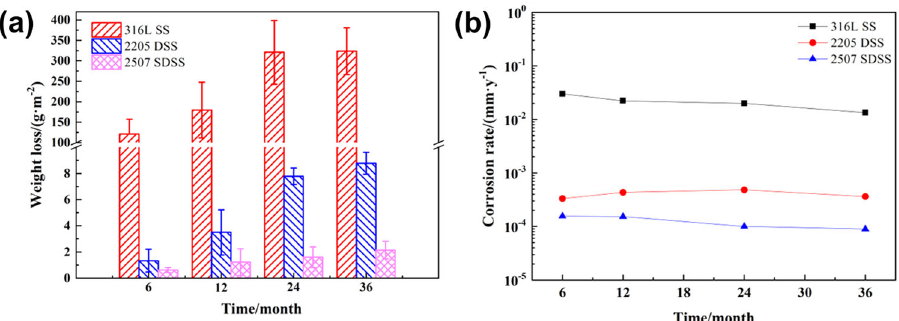
Fig. 3 Weight loss and corrosion rate of three stainless steel after immersing in natural seawater for different times. a Weight loss (error bars stand for the standard deviations from three independent sample), b corrosion